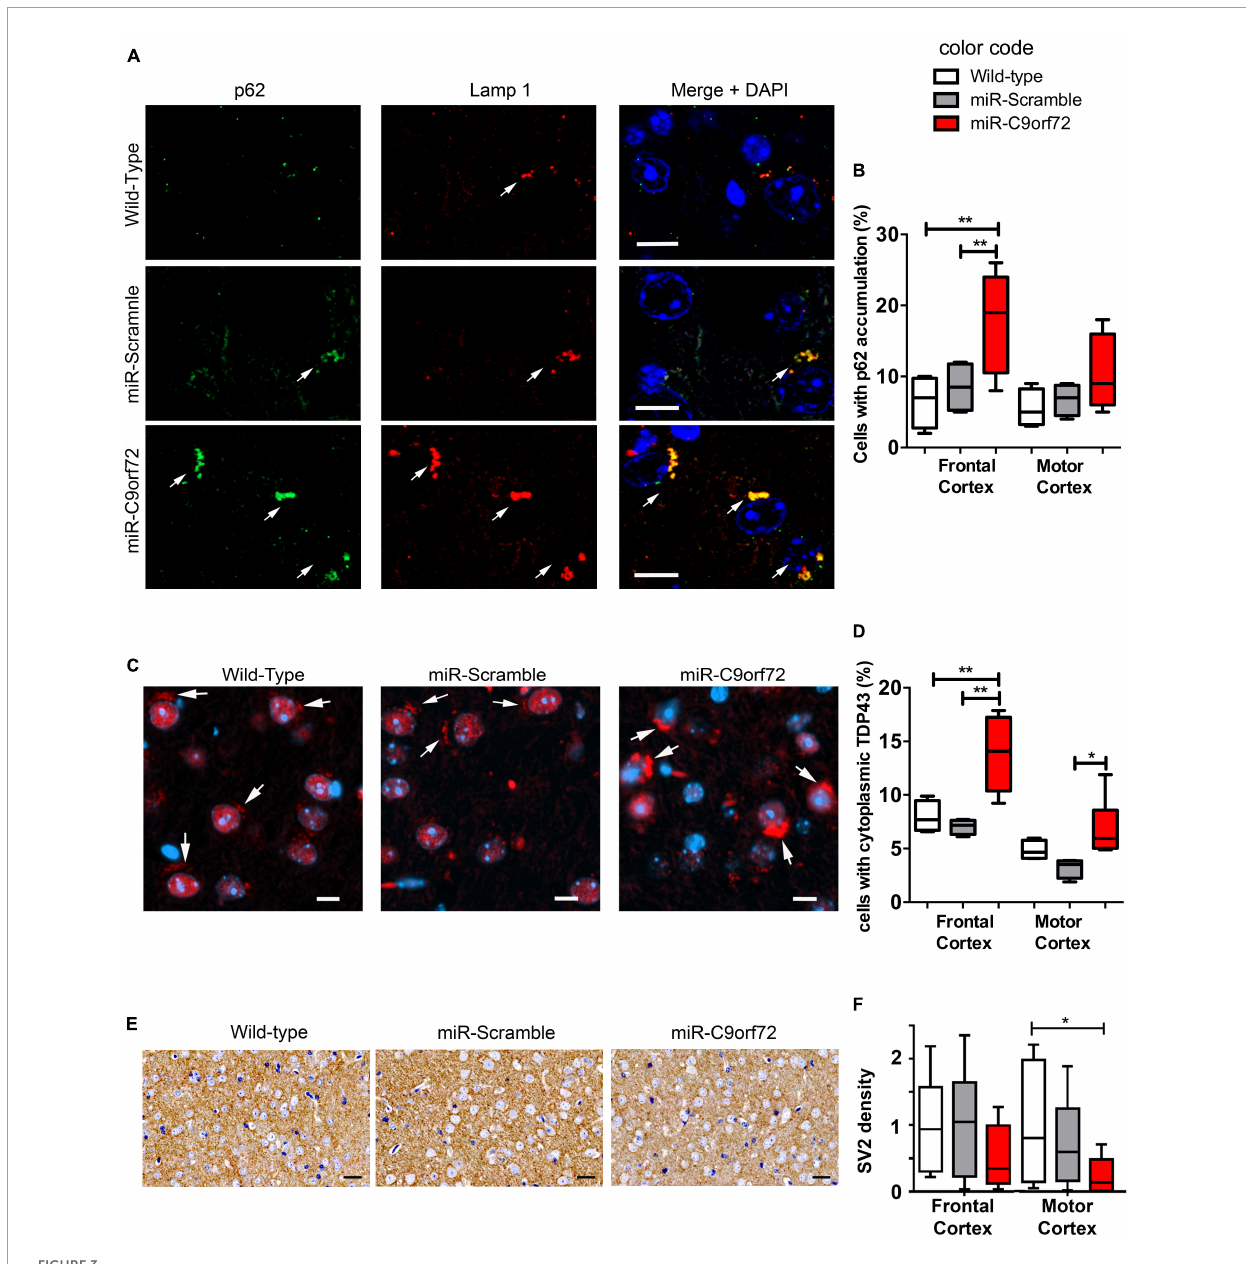
FIGURE3 C9ORF72 knockdown causes p62 and cytoplasmic TDP-43 accumulation in the cortex . (A) Immunofluorescence co-staining of the frontal cortex from wild-type, miR-Scramble mice and miR-C9orf72 using anti-p62 (green) and anti-Lamp1 (red). Accumulation of p62 positive large structures that stain positive for Lamp1 is observed in C9ORF72 deficient mice (arrows). Scale bar: 10 µ m. (B) Quantification of cells presenting p62 accumulation in the frontal and the motor cortex of controls and C9ORF72 deficient animals. (C) Immunofluorescence staining of TDP-43 (red)